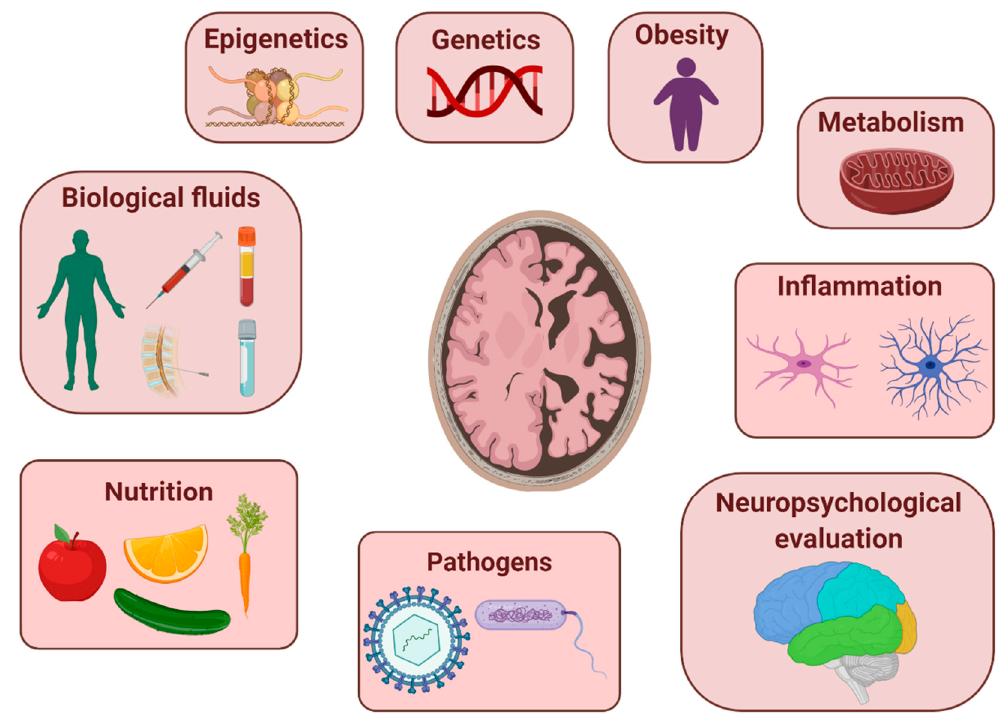
Figure 1. An overview of different research field for exploring potential biomarkers for Alzheimer’s disease. This figure was created with the support of BioRender.com.